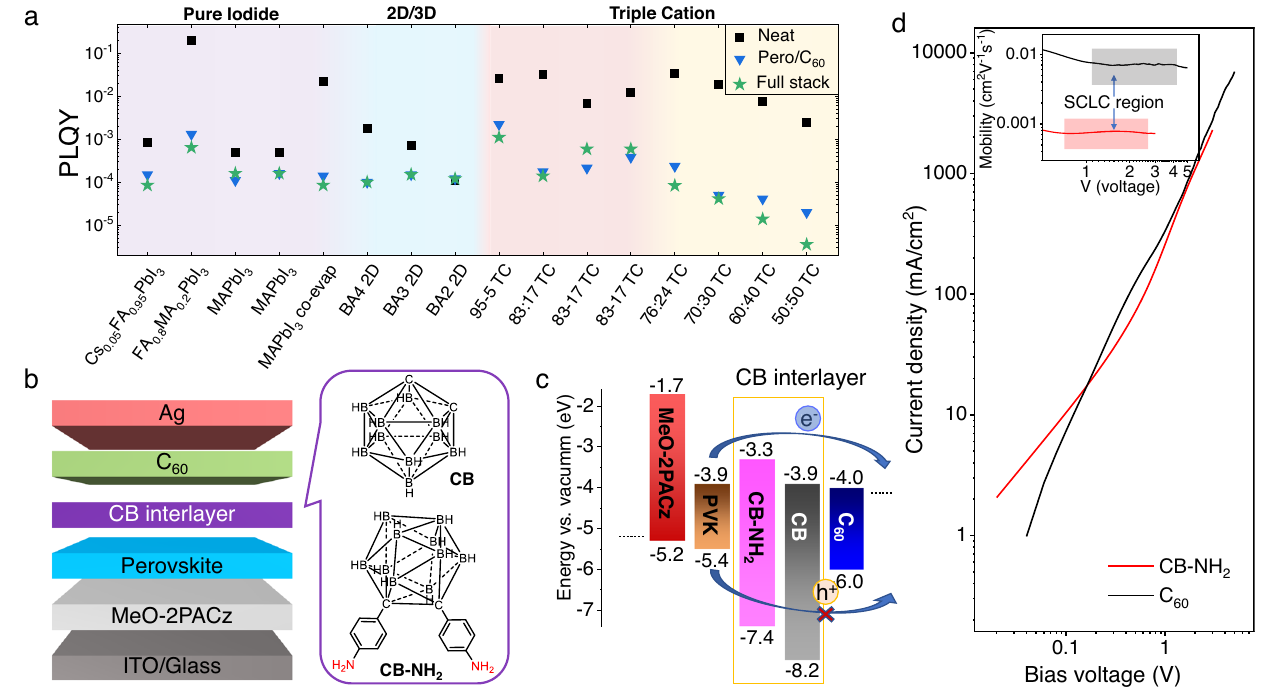
Fig. 1 | Universal photoluminescence quantum yield (PLQY) losses induced by C 60 , device structure and energy level diagram. a C 60 -induced recombination losses in various pin -type perovskite systems. Data reproduced with permission from Warby, J. et al. Understanding Performance Limiting Interfacial Recombina- tion in pin Perovskite Solar Cells. Adv. Energy Mater . 2022, 12, 2103567. 10.1002/ aenm.202103567 under a CC BY license https://creativecommons.org/licenses/by/ 4.0/.12 C 60 lowers the PLQY to ≈ 1×10 − 4 − 1×10 − 3 of the neat layer, for various per- ovskite compositions represented by the different shading, such as methyl ammonium lead iodide (MAPbI 3 ), double cation (FA 0.8 MA 0.2 PbI 3 ) and triple-cation perovskites(Cs 0.05 FA x MA y Pb(I x Br y ) 3 )whicharedenotedas “ TC ” ,wherethex:yratio